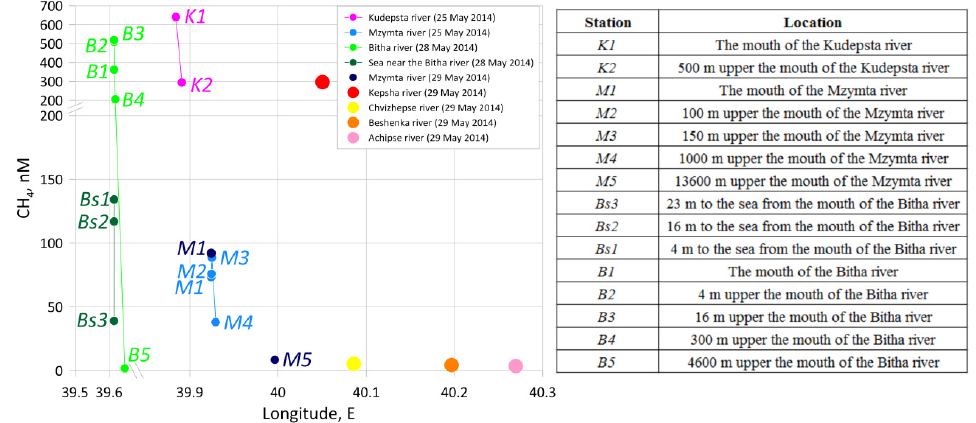
Figure 6. Dissolved methane content in the river waters of the Sochi region (as well as in the sea waters near the mouth of the Bitha River), May 2014.